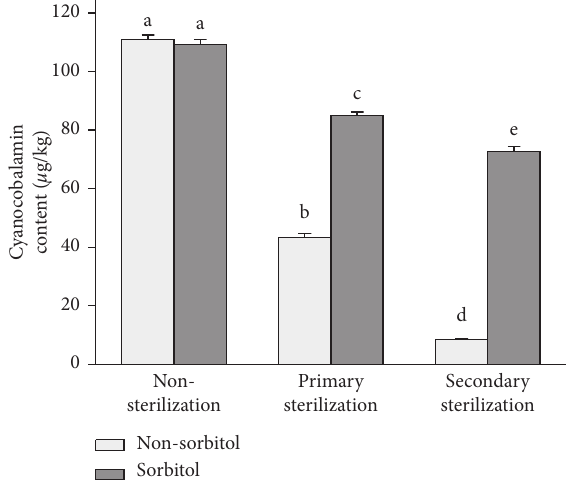
Figure 5: Cyanocobalamin content by the production process in commercial and modified medical foods. The medical foods had a matrix containing ascorbic acid and were sterilized twice (primary sterilization, 135 ° C, 72s; secondary sterilization, 124 ° C, 10min). The modified medical food was added 0.25% (w/v) sorbitol. Values with different letters (a–e) are significantly different at p < 0 . 01 by post hoc Tukey’s